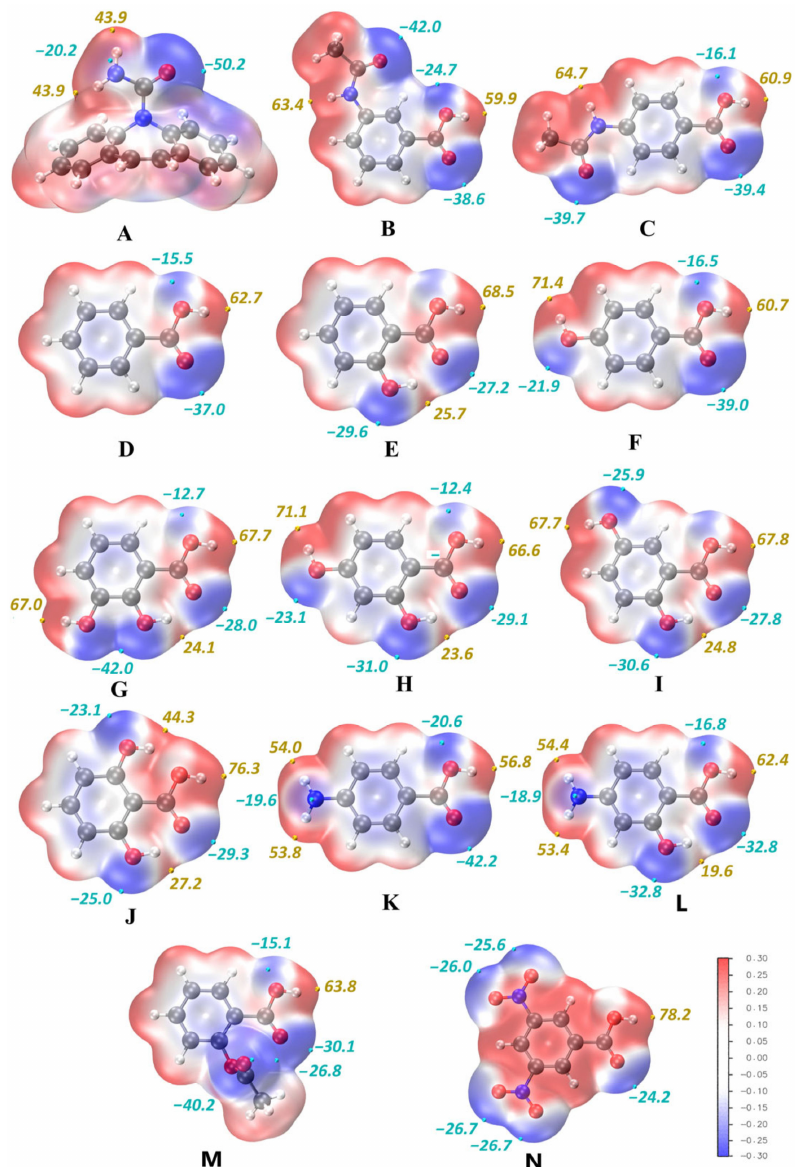
Figure 4. Molecular electrostatic potential mapped over total electron density ρ = 0.002 isosur- face for relaxed molecules of CBZ ( A ) and benzoic acid derivatives that form cocrystals with CBZ: 3AcAmBA ( B ), 4AcAmBA ( C ), benzoic acid ( D ), salicylic acid ( E ), 4-hydroxybenzoic acid ( F ), 2,3-dihydroxybenzoic acid ( G ), 2,4-dihydroxybenzoic acid ( H ), 2,5-dihydroxybenzoic acid ( I ), 2,6-dihydroxybenzoic acid ( J ), 4-aminobenzoic acid ( K ), 4-aminosalicylic acid ( L ), acetylsalicylic acid ( M ), 3,5-dinitrobenzoic acid ( N ). The isosurfaces are color-coded in the range between − 0.3 a.u. (blue) and +0.3 a.u. (red). The numbers display the selected ESP values of minima (cyan points) and maxima (yellow points) of selected electrostatic potential values in kcal mol − 1